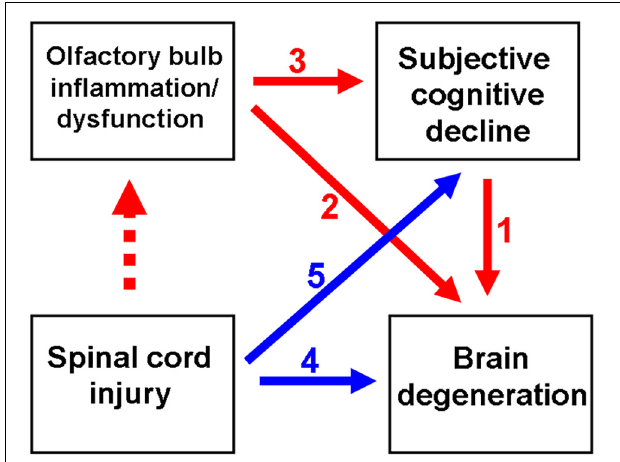
FIGURE 1 | Schematic diagram depicting spinal cord injury (SCI)-mediated olfactory dysfunction and the subsequent subjective cognitive decline (SCD)/neurodegenerative dementia. Olfactory dysfunction is an early indicator of neurological diseases, including SCD and neurodegenerative dementia. Previous studies have reported the correlation between SCD and neurodegenerative disease (ND) (indicated as red arrow no. 1). Generally, olfactory impairment is involved in the progression of ND (indicated as red arrow no. 2) or the progression of SCD to ND (from red arrow no. 3 to 1). Thus, SCI promotes ND (indicated as blue arrow no. 4), as well as the progression from initial SCD to ND (from blue arrow no. 5 to red arrow no. 1). This study demonstrated that SCI promotes neuroinflammation in the olfactory bulb at an ultrarapid stage after SCI. Thus, SCI may mediate the pathological mechanisms of